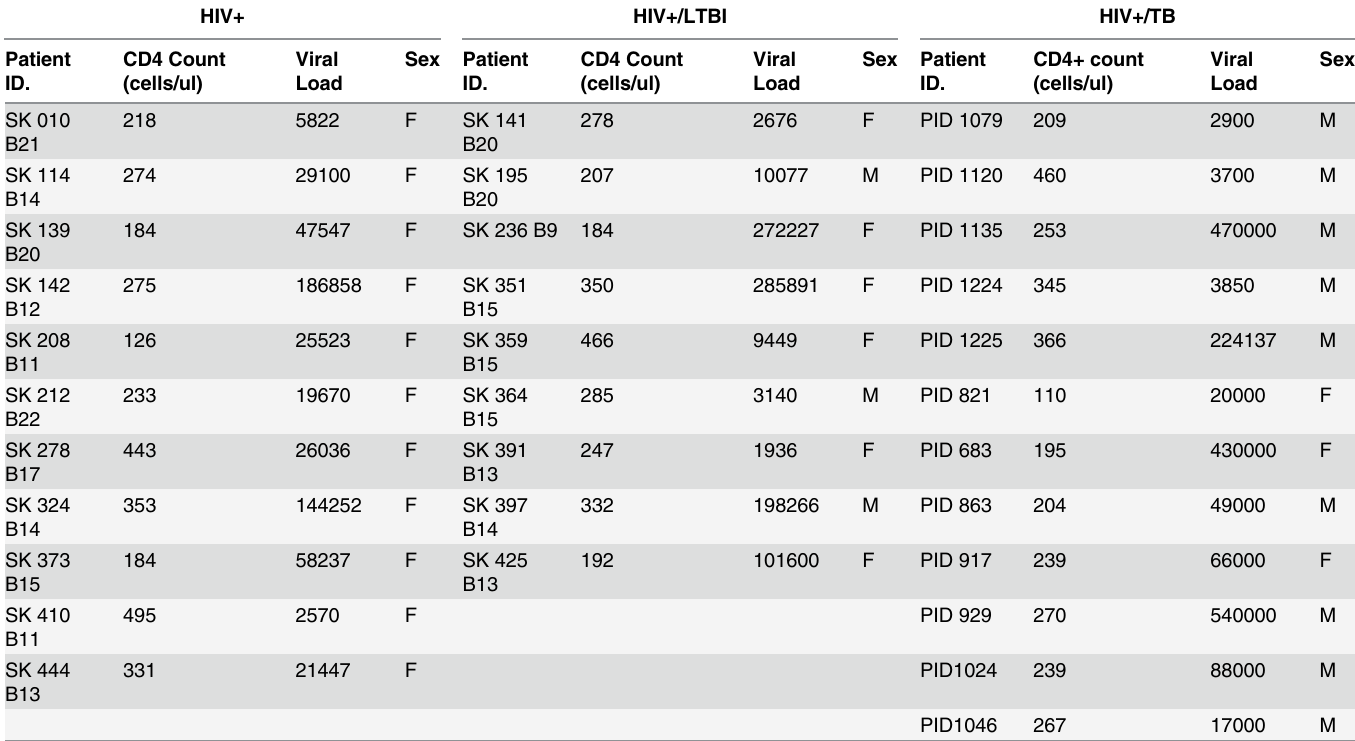
Table 1. Viral load and CD4 count information for study participants. HIV+ HIV+/LTBI HIV+/TB Patient